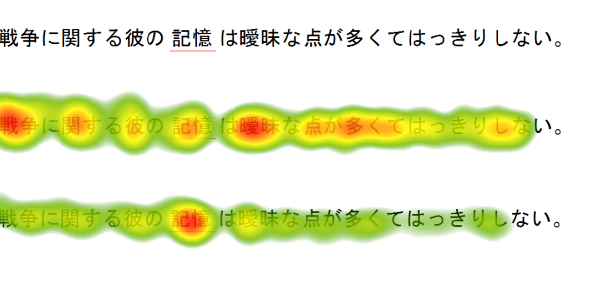
Figure 5. Example sentence of the two-sentence condition. Top panel: original Japanese sentence (English translation; Much of his memory regarding the war is unclear, underlined word is memory ). Middle panel: The heatmap of 15 participants under the READ condition. . Bottom panel: The heatmap of the other 15 participants under the RST condition. The red color indicates the area much gazed .